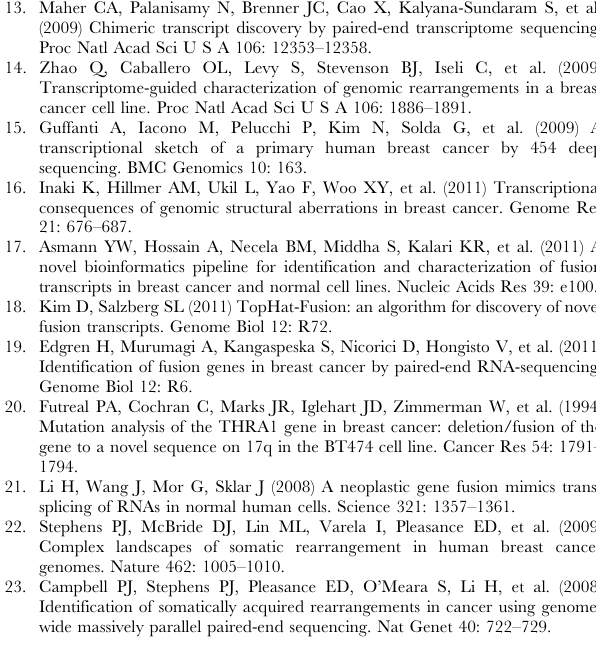
Table S1 False positive fusion transcript candidates. Three Table S2 Genomic sequences of fusion break points. Table S3 Several fusion transcripts code for functional protein domains. Type of fusion transcript (promoter-coding, coding- coding, coding-3 9 UTR) is indicated along with the sequences of the 3 9 and 5 9 fusion genes taking part in the fusion transcripts. Domain predictions of the fusion transcripts are implied as predicted by SMART [38,39]. * denotes threshold predictions. Table S4 Primers used in the